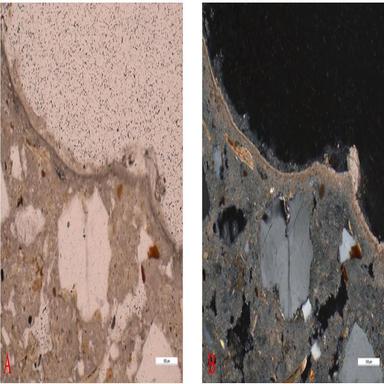
Photomicrographs of the sample HG_S_AL_05, transmitted light, parallel polars (A) and crossed polars (B). In this detail it is possible to observe the secondary crystallization of calcite on the internal surface of a large pore. Measurement reference bar = 200 μm.